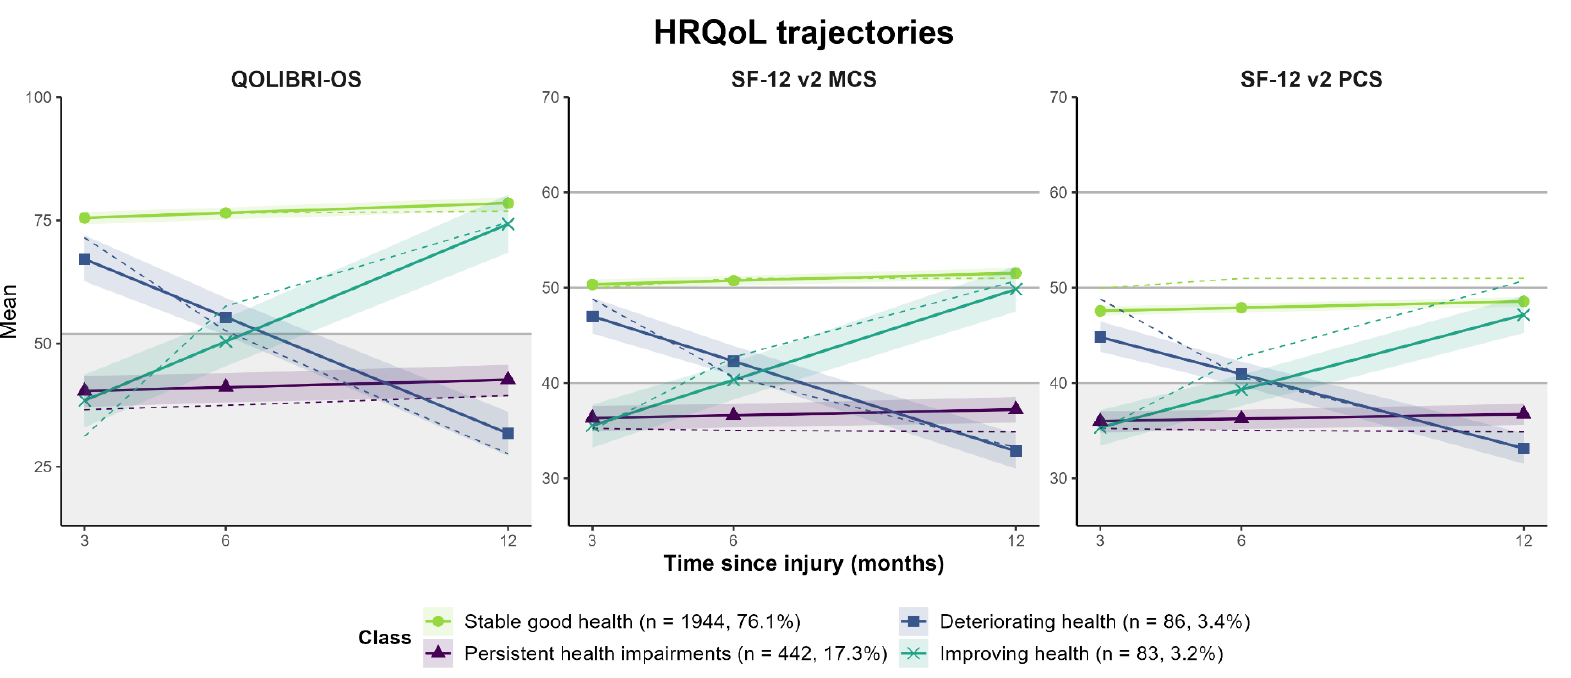
Figure 2. Generic and disease-specific HRQoL trajectories (QOLIBRI-OS, SF-12 v2 MCS/PCS) for the four-class solution. Solid, colored lines indicate predicted trajectories, dashed lines the observed values. Shaded areas around lines indicate 95% confidence intervals for predicted values. Gray lines mark cut-off for unfavorable values for the QOLIBRI-OS (<53) as well as mean (=50) and standard deviation (+/ − 10) for the SF-12v2 MCS/PCS. Gray area marks values below the cut-off for unfavorable levels of quality of life (QOLIBRI-OS < 52, SF-12v2 MCS/PCS < 50).